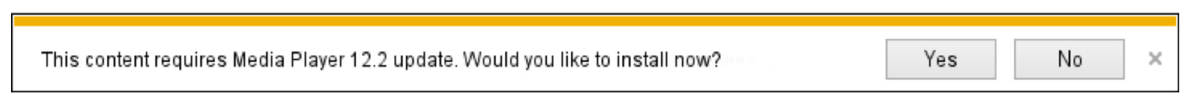
Fig. 1 Example of deceptive images in Amazon S3 bucket cicloudf ront used for malvertising. The image was shown at the bottom of a webpage as an update notification to lure visitors to download